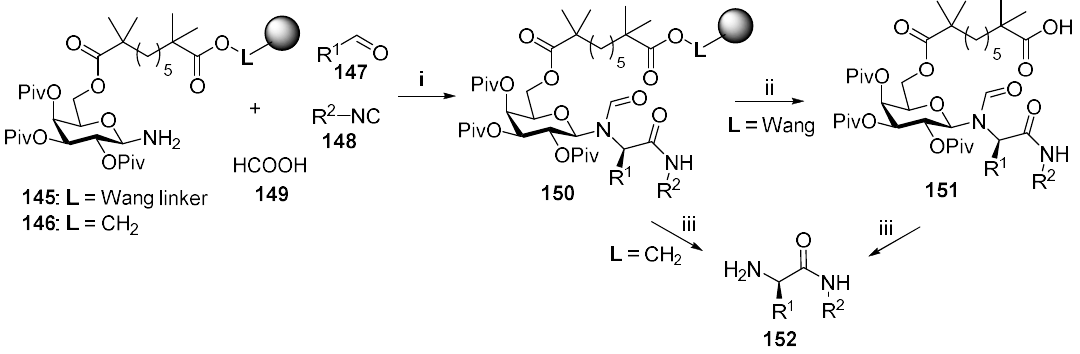
Scheme 30. The first diastereoselective Ugi reaction on the solid phase.